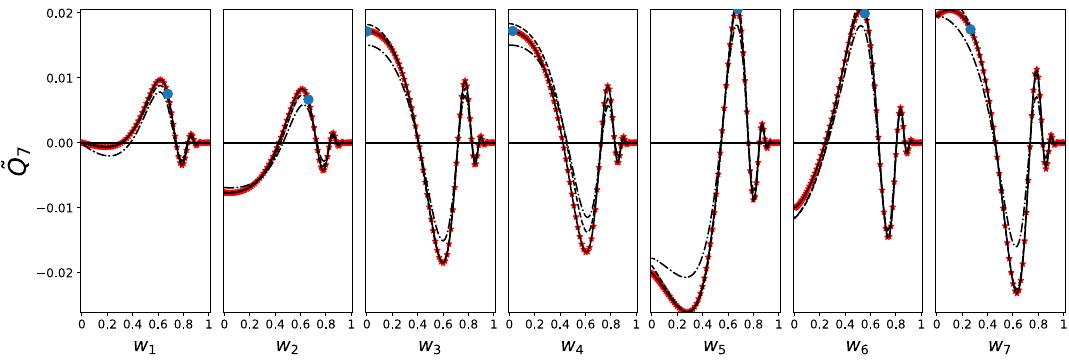
˜ − 2 (red stars) with the TCI of rank χ ¼ 2 , 4, 40 (dash-dotted, dashed, and Q 7 for ϵ d ¼